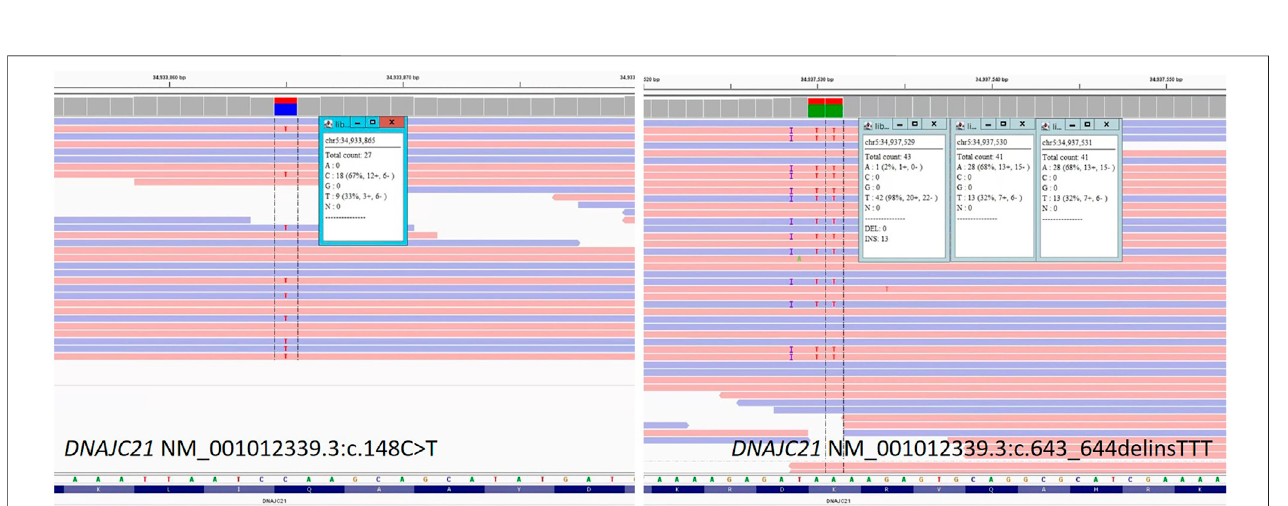
FIGURE 2 | SD-OCT images from horizontal cross section through the retina showed in both eyes (A) left eye and (B) right eye: increased central foveal thickness (CFT was 251 μ m for the left eye and 250 μ m for the right eye), absence of the foveal depression, preservation of the inner retinal layers in the fovea (foveal hypoplasia), intact ellipsoid zone (EZ) in the fovea, disruption areas in the external limiting membrane (ELM), decreased outer nuclear layer (ONL) thickness, and weak delimitation of outer segments of photoreceptors and choroidal thinning at the nasal extremity in the retinal pigment epithelium (RPE).